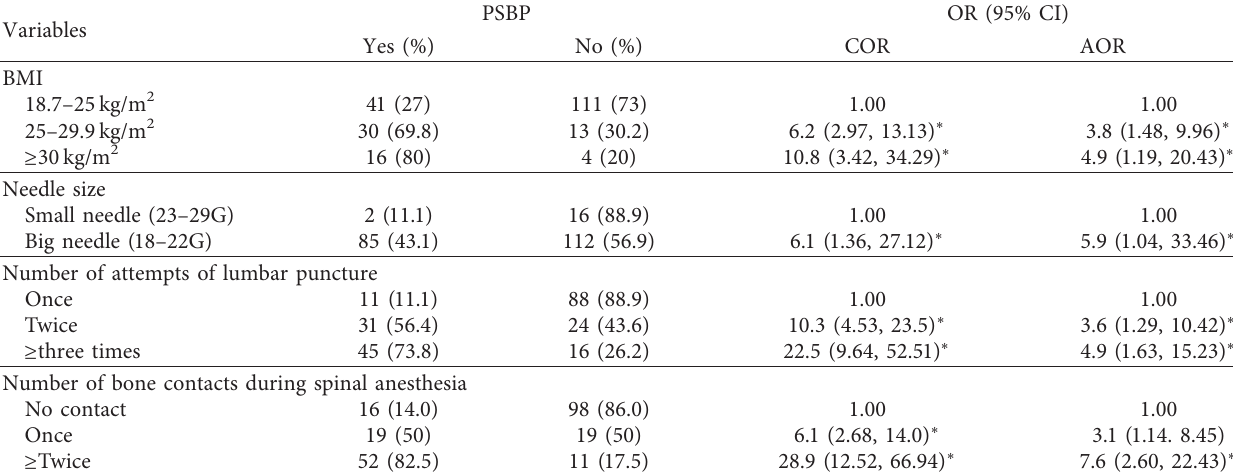
Table 3: Factors associated with PSBP in patients who underwent the surgical procedure under spinal anesthesia, Northwest Ethiopia,